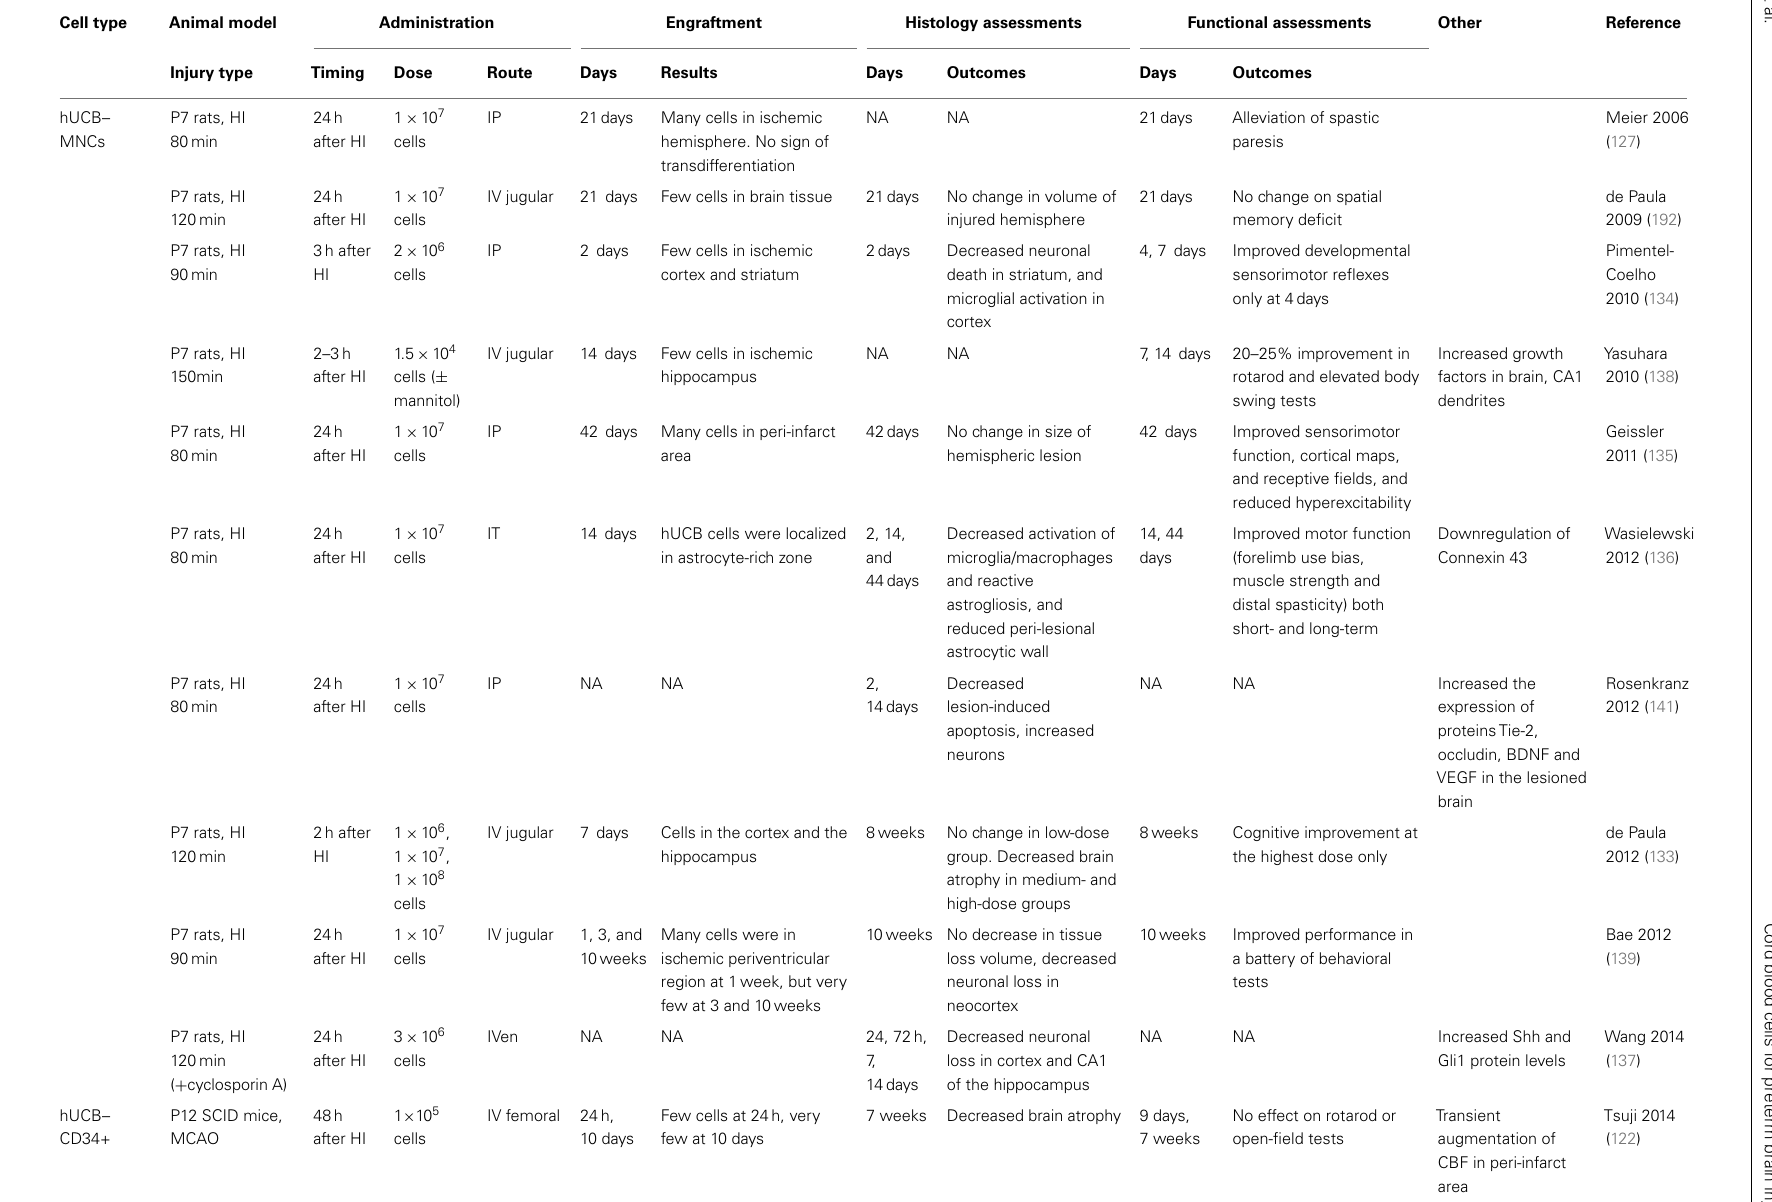
Table 1 | Outcome of umbilical cord blood interventions in neonatal hypoxia–ischemia . Cell type Animal